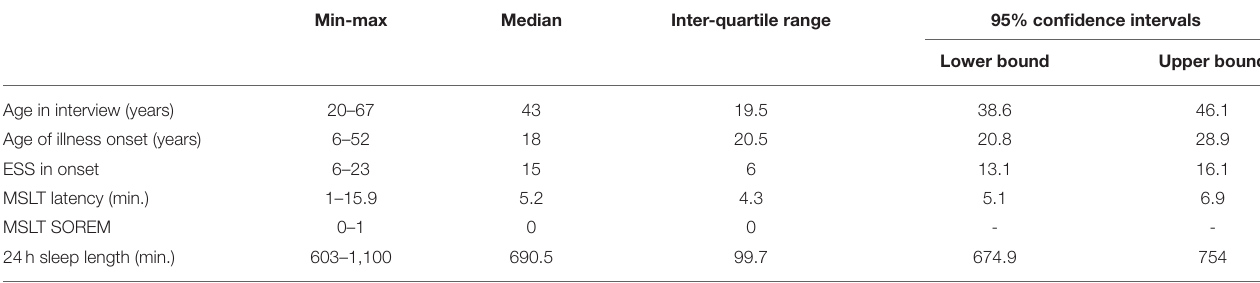
TABLE 1 | Basic age and sleep characteristics of the participants.